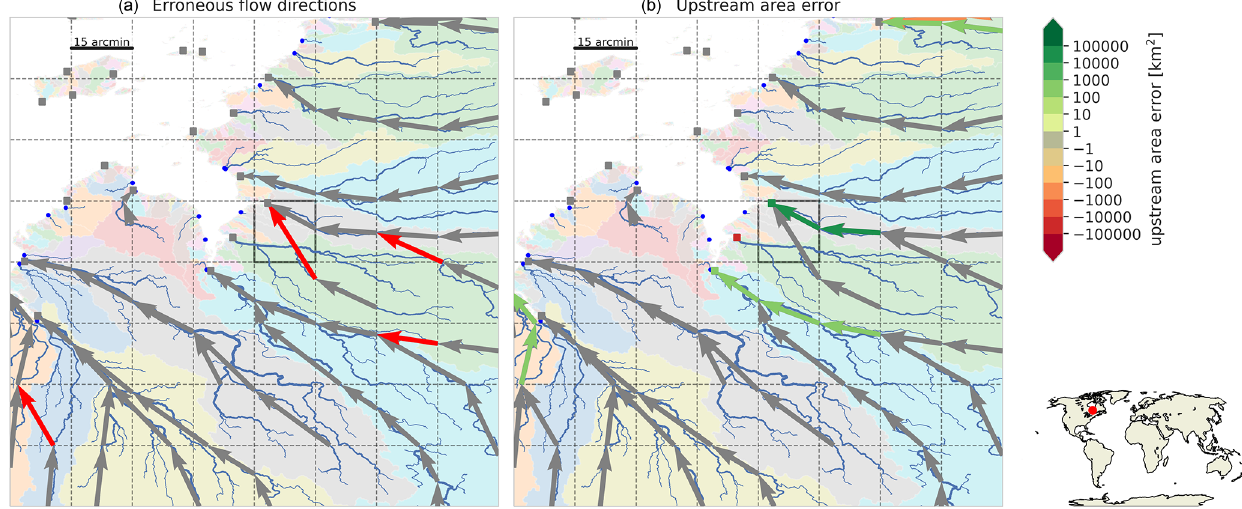
Figure C5. Largest basin (42017km 2 ) with a relative upstream area error of more than 10% at the 15arcmin resolution indicated with a highlighted cell. See the caption of Fig. C1 for a full description.